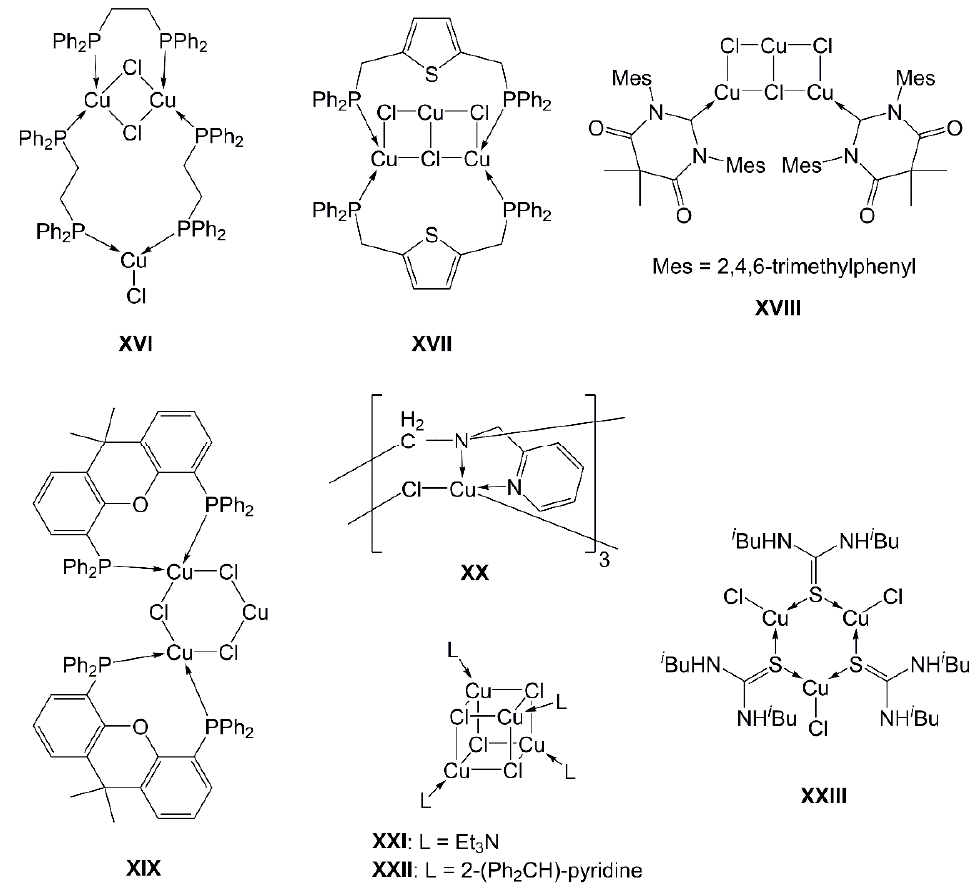
Figure 13. Selected examples of oligonuclear complexes with (CuCl) n cores ( n = 1, 2, 3, 4; XVI − XXII ) as well as an example of a complex with bridged (CuCl)-motifs ( XXIII ). For reasons of clarity of presentation, formal lone pair donation by L-type ligands (such as phosphanes) is indicated by a dative bond arrow, whereas X-type bonds (for example CuCl, even in case of bridging bonds of mixed L,X-type) are indicated by a regular bond dash.